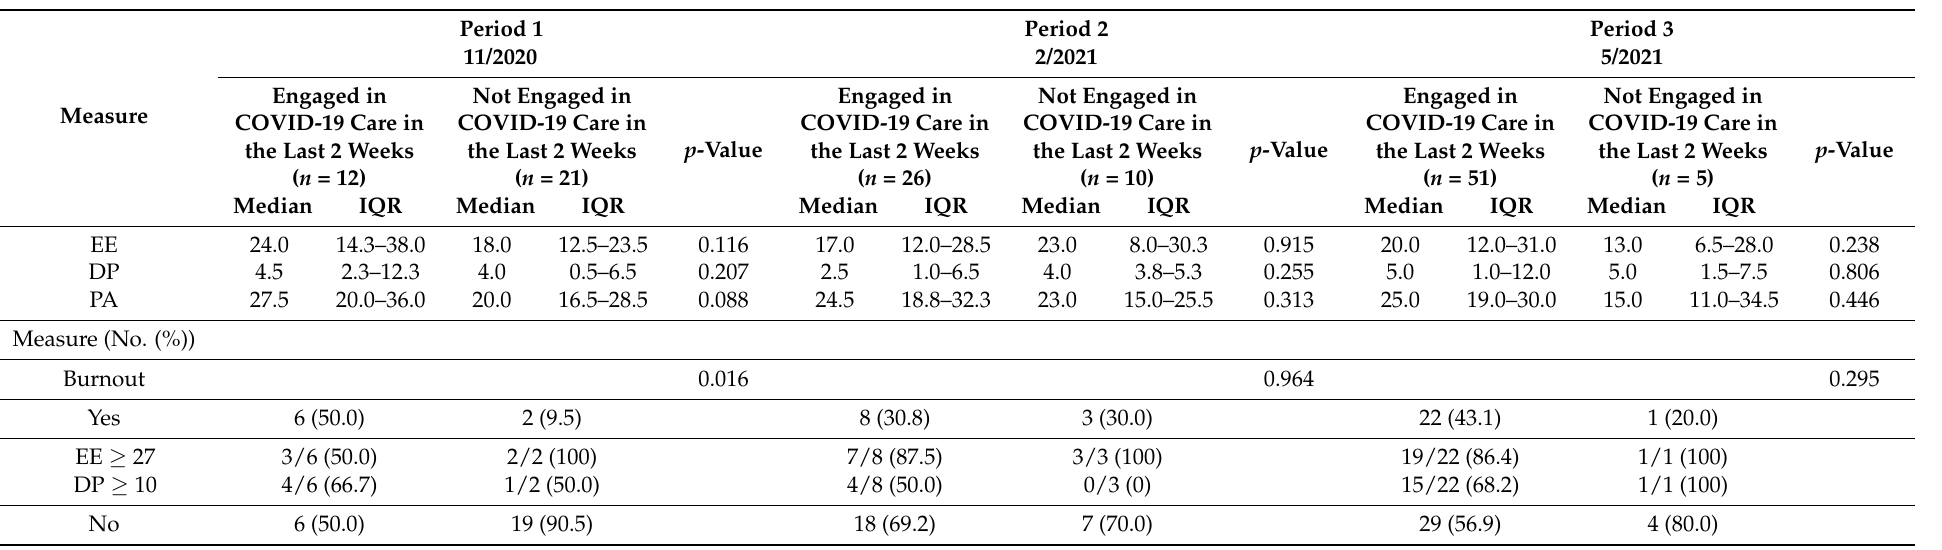
Table 2. Results of the Maslach Burnout